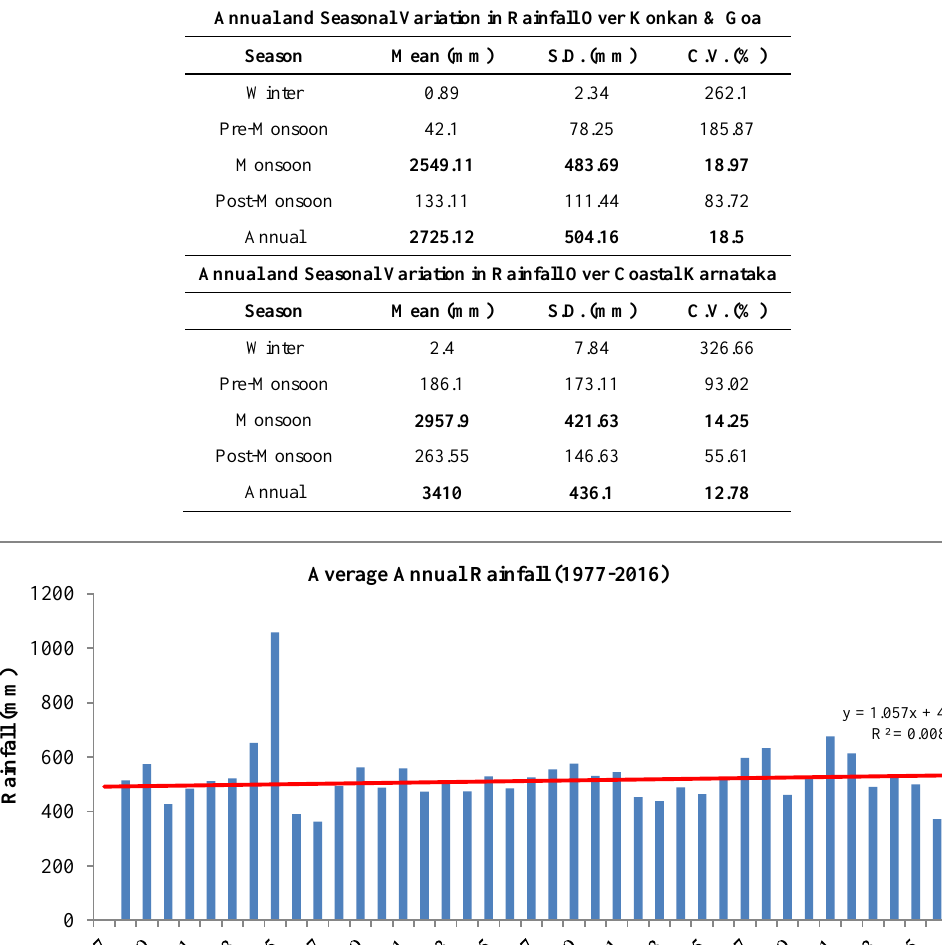
Table 1. Annual and Seasonal Variation In rainfall over both the meteorological sub-divisions Annual and Seasonal Variation in Rainfall Over Konkan & Goa